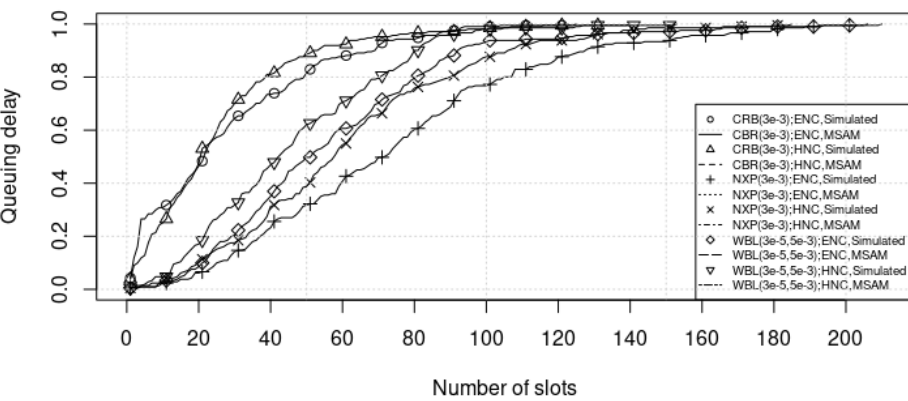
Figure 7. The Cumulative Distribution Functions of the queuing delay.